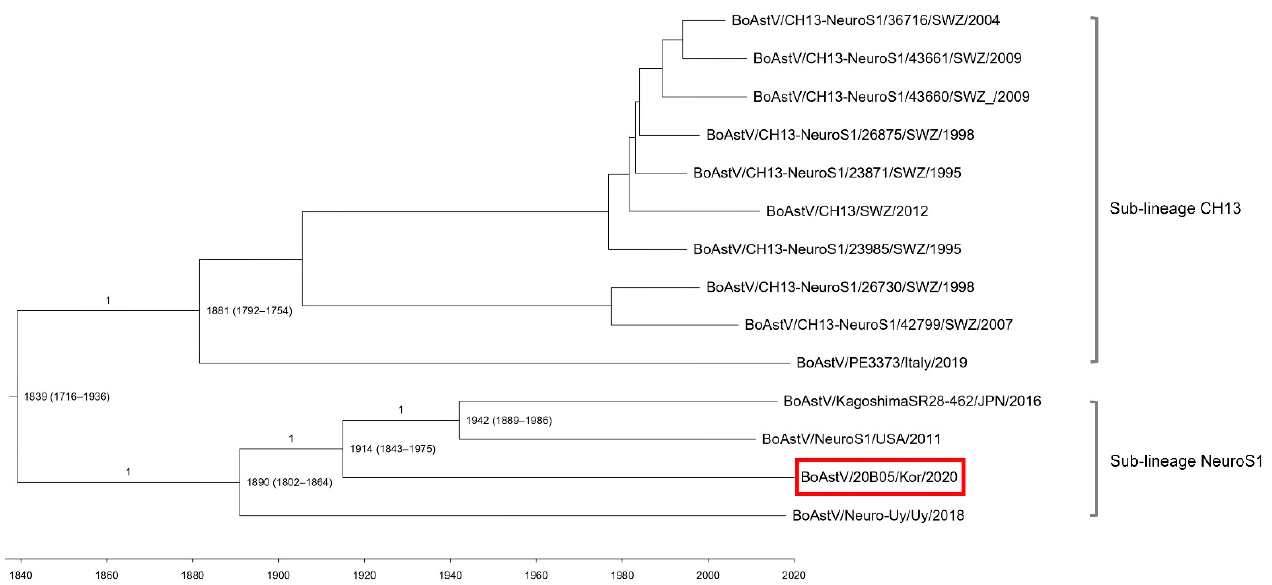
Figure 3. Maximum clade credibility tree generated using the analysis of concatenated open reading frames (partial RdRp and ORF2) sequences of BoAstV 20B05 (red box). The posterior probability values are shown in the branches, and the years of origin for each clade with the 95% highest probability interval are represented in each node.